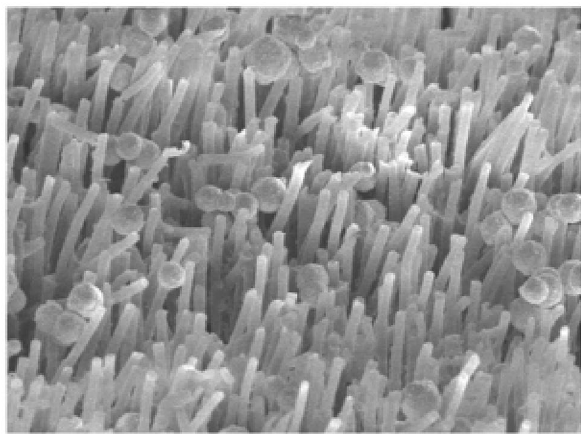
Fig. 5 Example of a “gecko” type of nanostructure (fiber length 18 µm, diameter 0.6